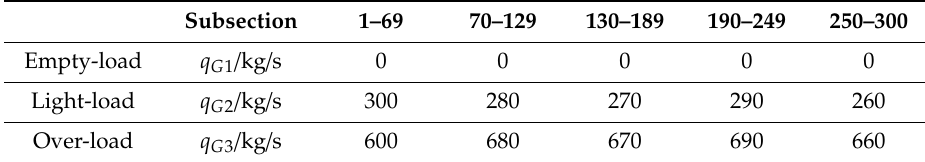
Table 4. Section and corresponding load of the belt